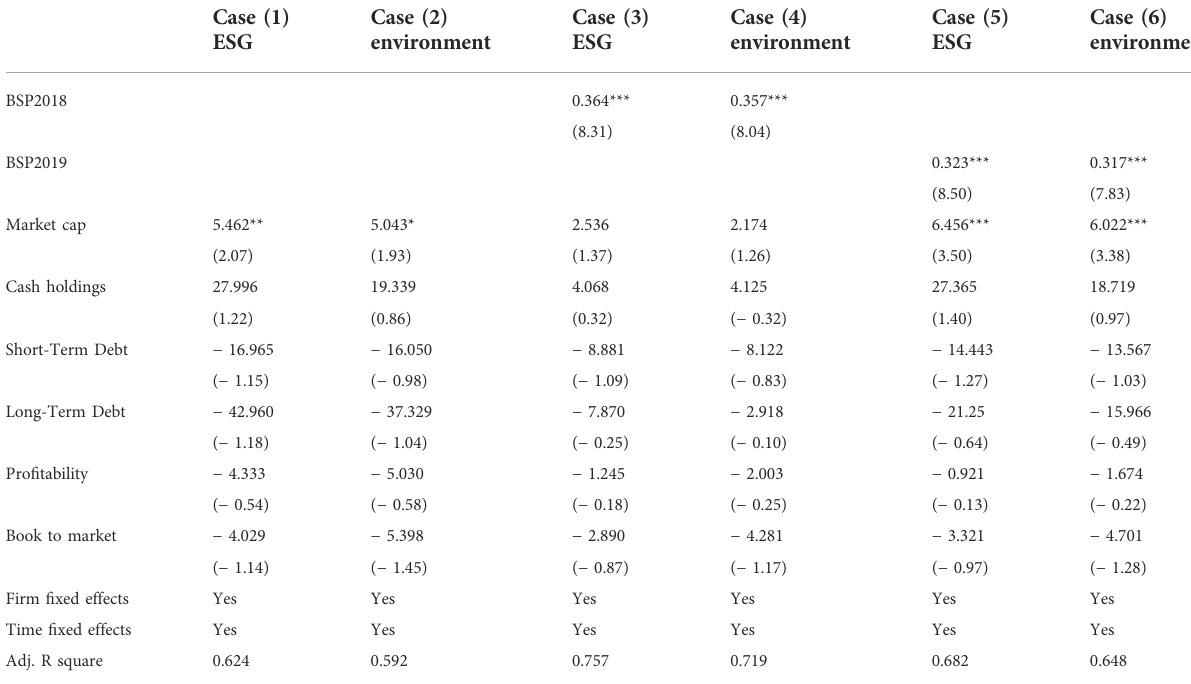
TABLE 4 Policy effects of the “ Blue Sky Plan ” on ESG investment in China ’ s steel